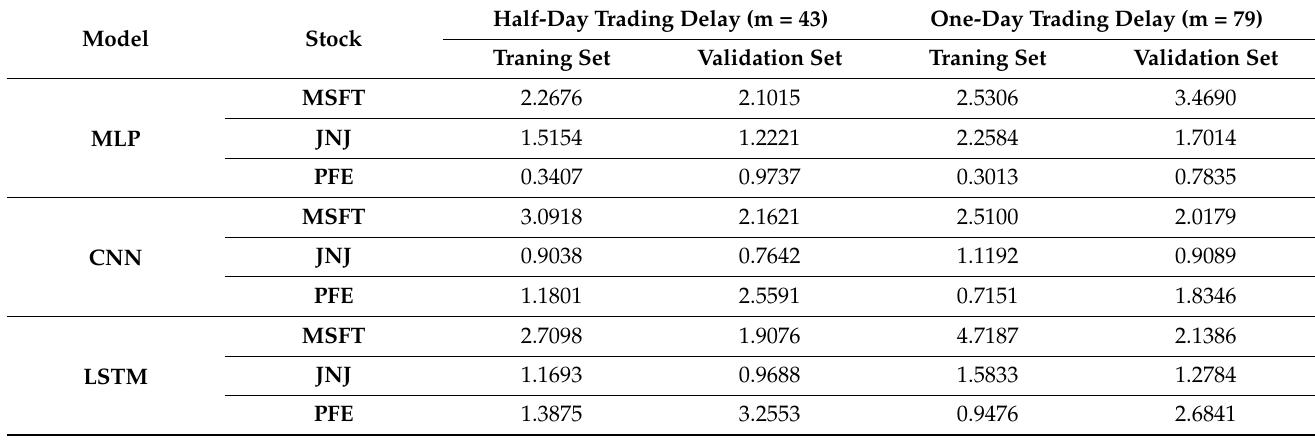
Table 4. The root mean square error of three deep learning